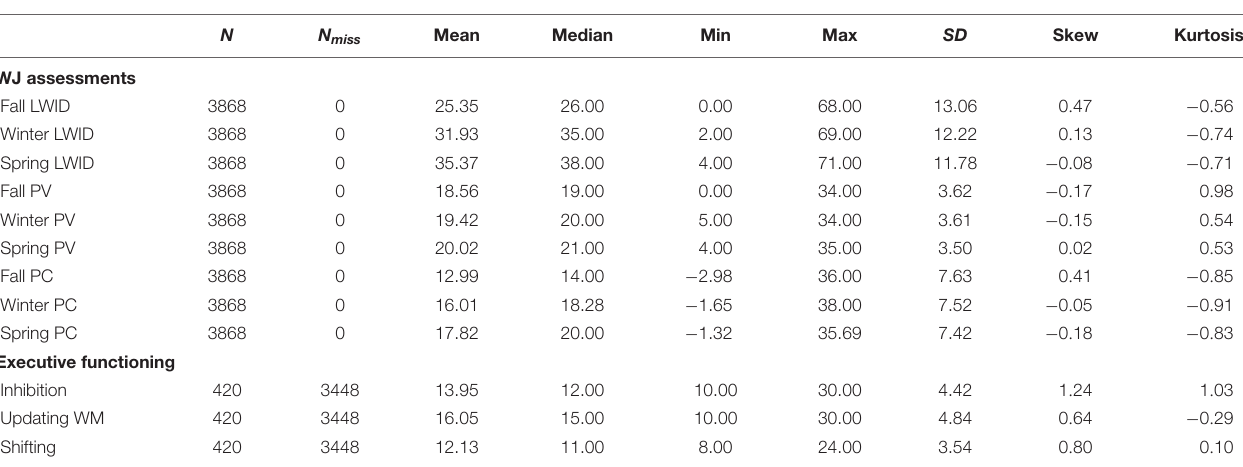
TABLE 2 | Post-imputation descriptive